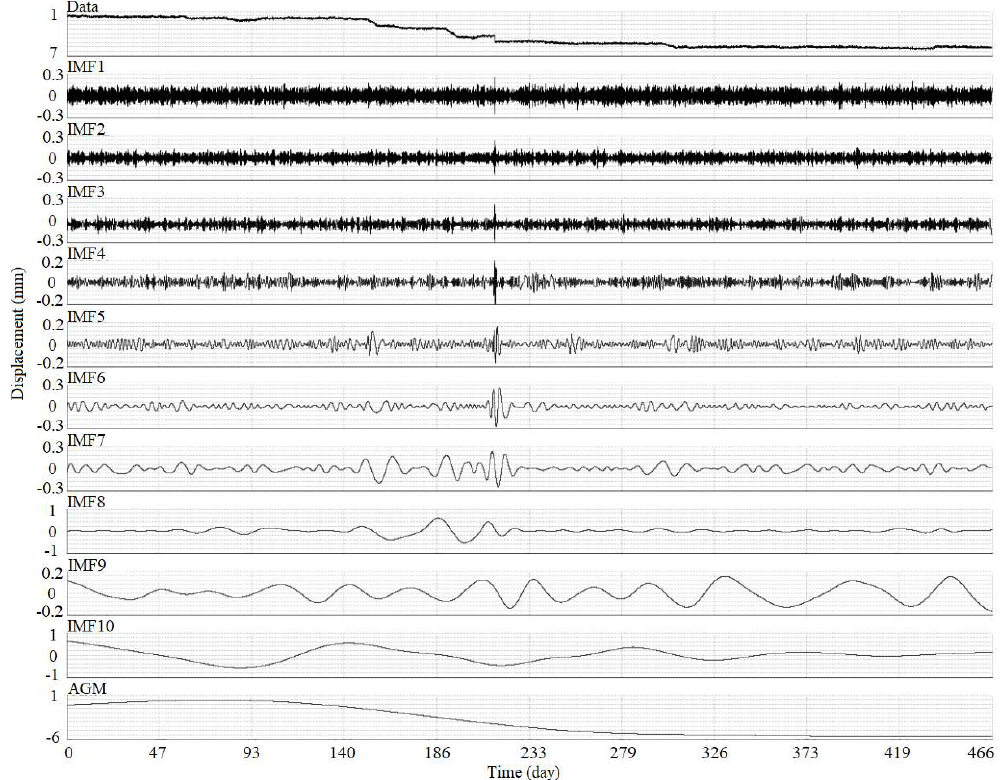
Figure 8. Decomposed intrinsic mode functions (IMFs) using the ESMD method for the time-series displacement in the X direction of the 4th node of the 4 m-long SAA.